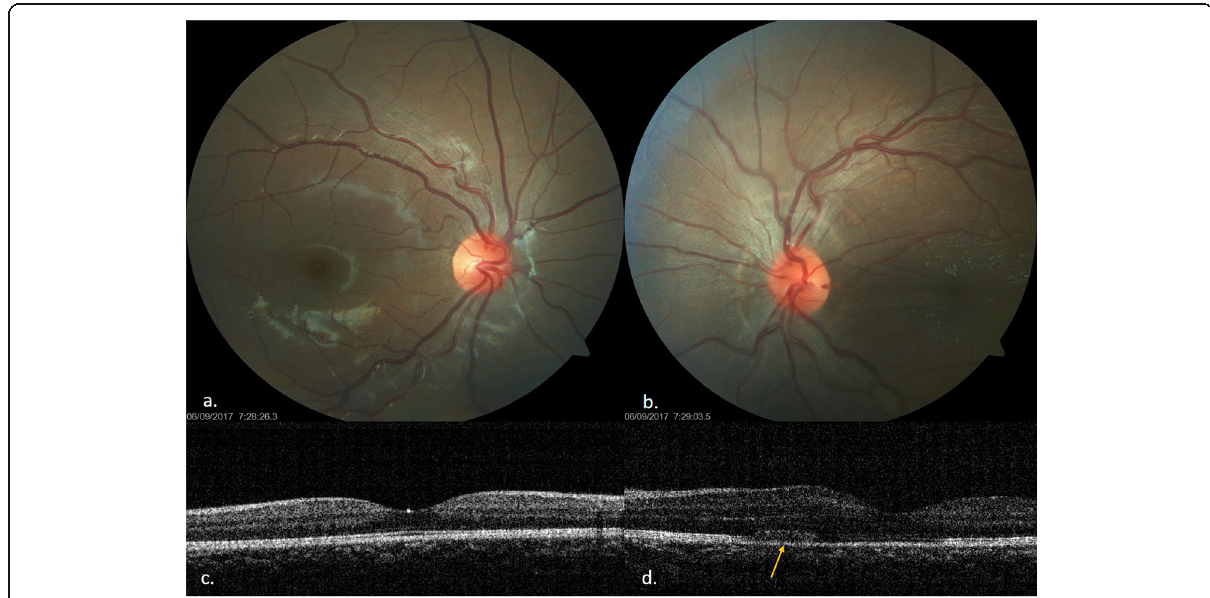
Fig. 3 Follow-up 2 weeks. a Normal right eye fundus. c OCT of right eye. b Resolved disc edema and residual retinal striae. d OCT also shows decrease in retinal thickness, mild swelling of outer retinal layers with complete absorption of sub retinal